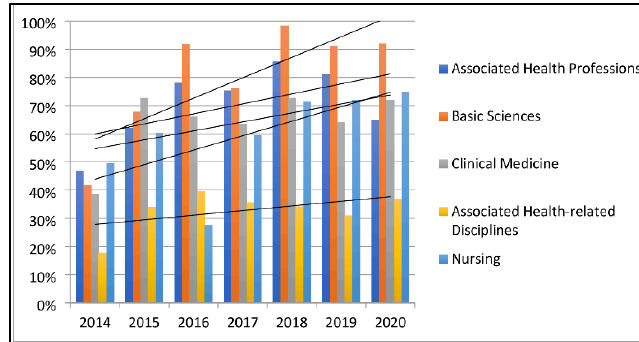
Figure 1 Temporal trends in DCT matching titles